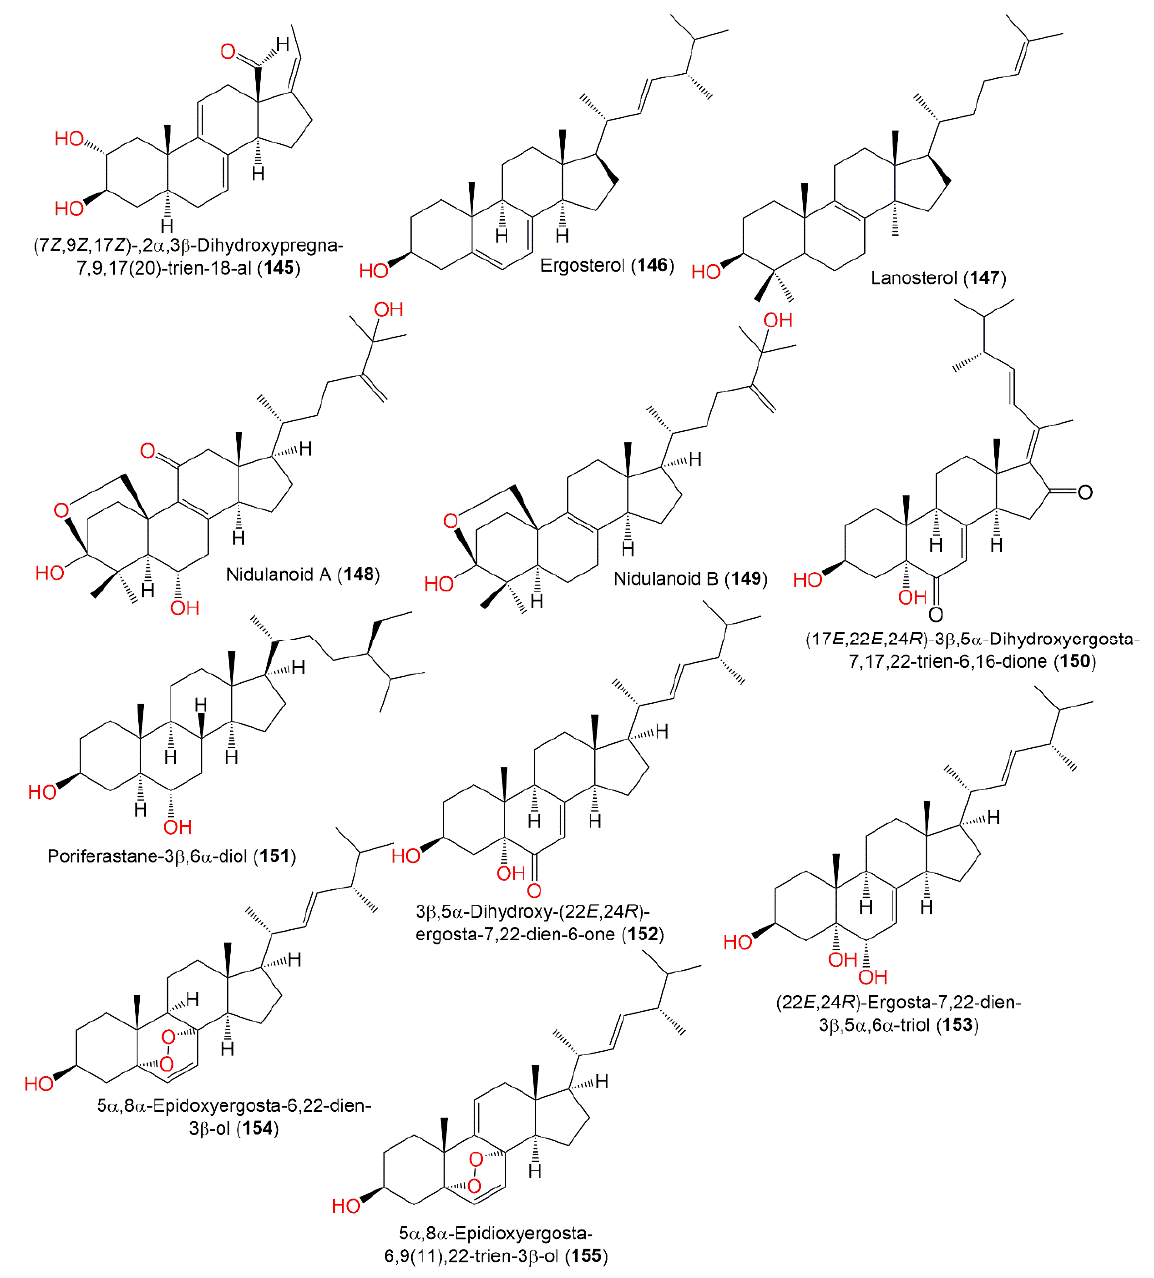
Figure 16. Structures of sterols ( 145 – 155 ). These metabolites were assessed for cytotoxic potential in vitro vs. the PC12 cell line in the MTT assay. Only 145 possessed moderate potential (IC 50 7.34 µ M) compared to doxorubicin (IC 50 5.71 µ M) [41]. Compound 167 , reported from the EtOAc broth extract of Emericella nidulans , was mildly active as an HCV inhibitor (IC 50 47.0 µ g/mL) relative to HCV-12 (IC 50 1.5 µ g/mL) [47] (Figure 17, Table